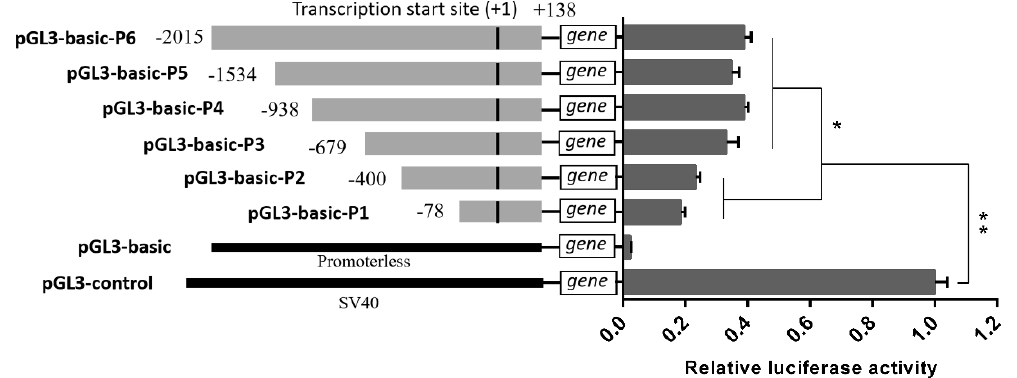
Figure 2. Luciferase assays for porcine MAOA promoter activity. Six luciferase reporter plasmids expressing successive truncations of the MAOA promoter sequence were constructed and transfected into 293T cells. The resulting firefly luciferase activity was normalized to Renilla luciferase activity and the relative values were presented as fold induction over the activity of the pGL3-basic vector. The basic activity value of negative control pGL3-control was set as 1. The location of each 5′-deletion sequence was indicated at the left of each bar. The relative luciferase activity values represent the mean ± SEM of three independent experiments. Statistical differences in luciferase activity were assessed using the one-way ANOVA analysis, * p < 0.05, ** p < 0.01.